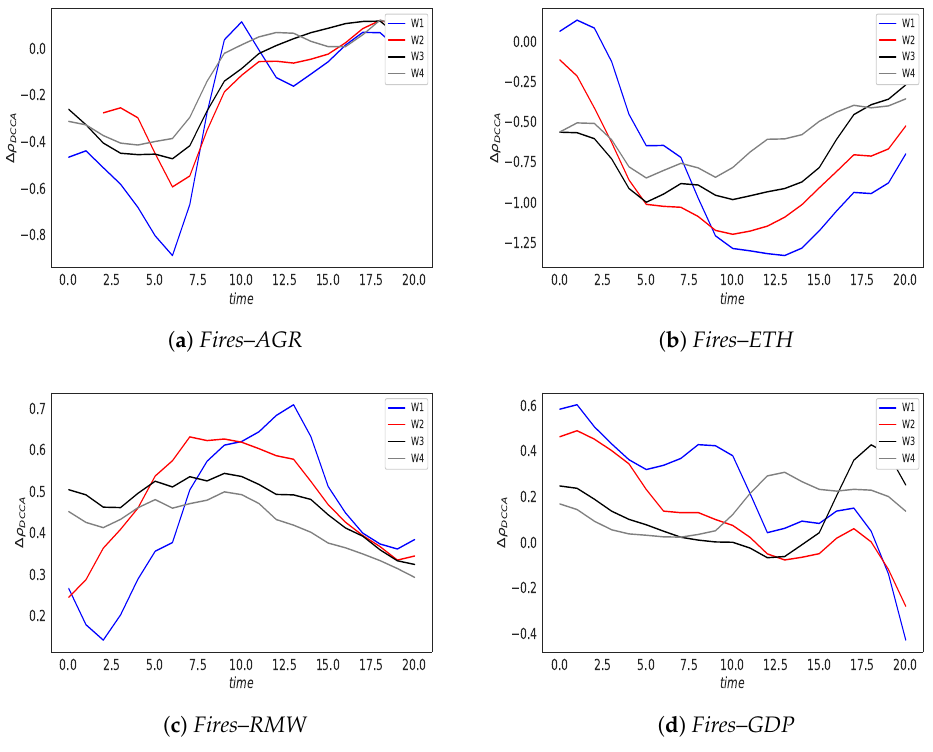
Figure 4. The ∆ ρ dcca for the different TS pairs and time scale of n = 6. Table 4. The normality test of ∆ ρ DCCA for W1 to W4. Significance level of 95% rejects the null hypothesis of normality, i.e., p - value < 0.05 (highlighted in bold). D’Agostino and Pearson’s Normality